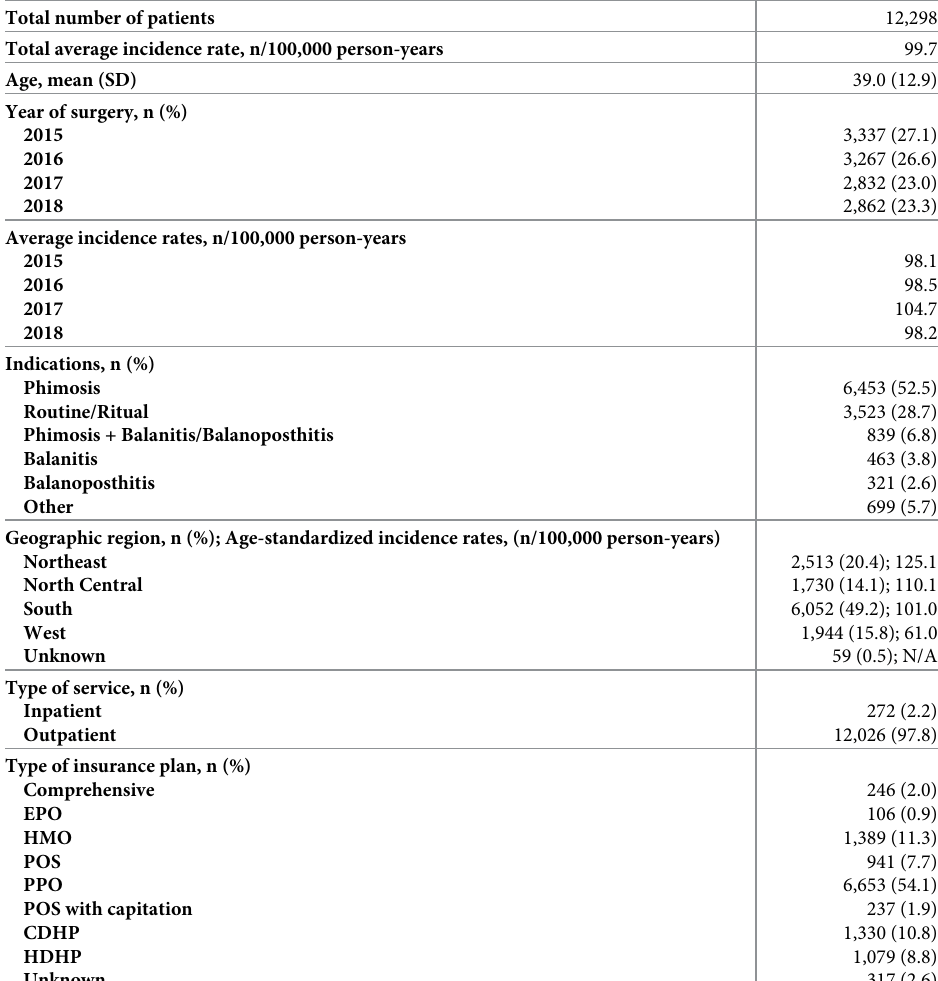
Table 1. Characteristics of study